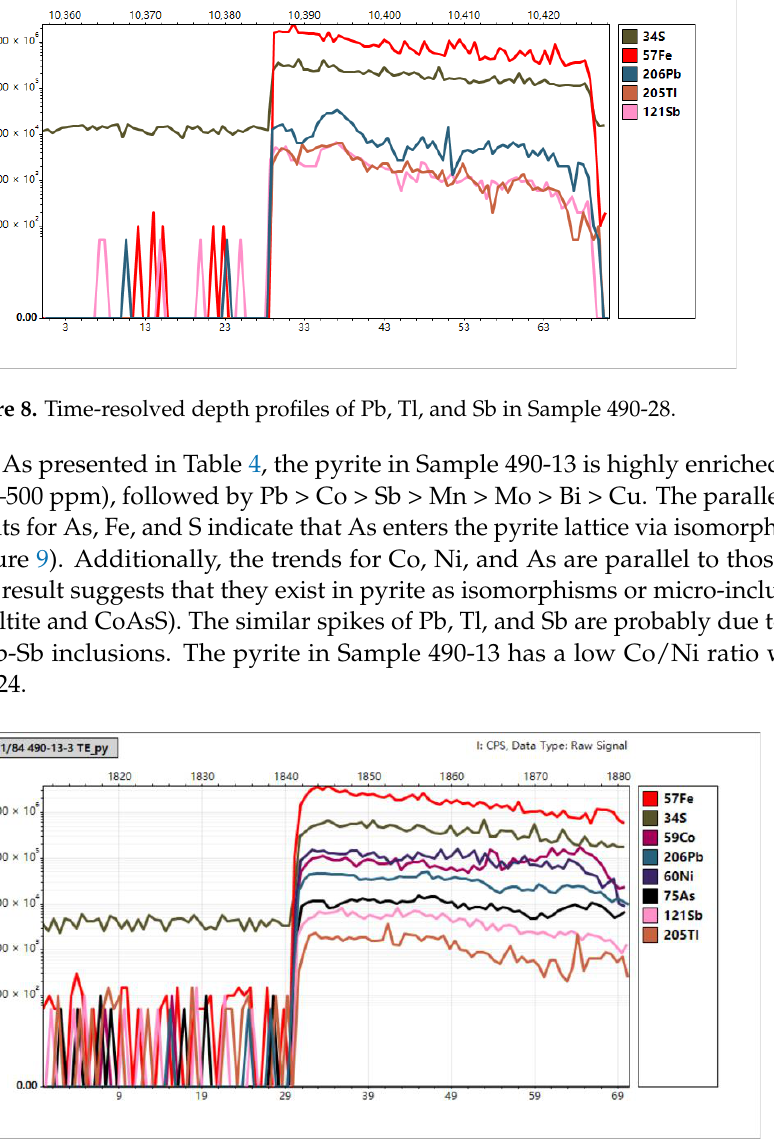
Figure 9. Time-resolved depth profiles of Co, Pb, Ni, As, Sb, and Tl in Sample 490-13.